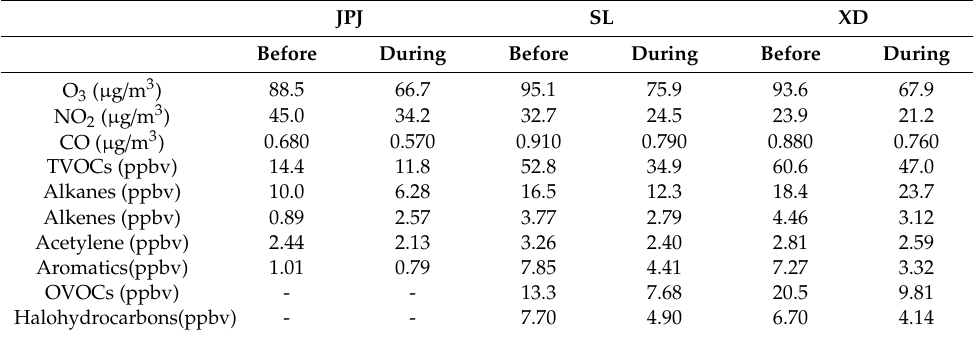
Table 1. Mean value of O 3 concentrations and ambient air pollutants before and during control periods at each monitoring site.